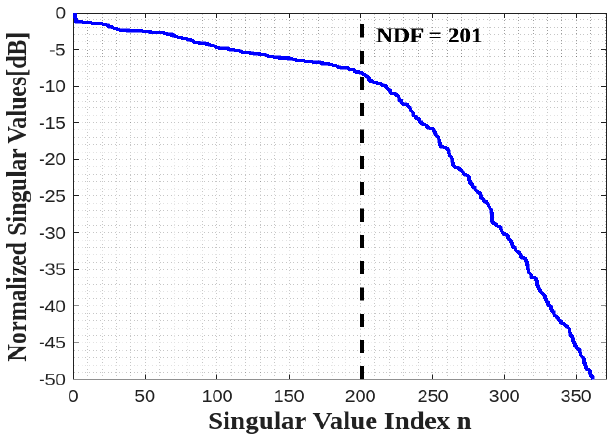
Figure 4. The behavior of normalized singular values for one XY face.